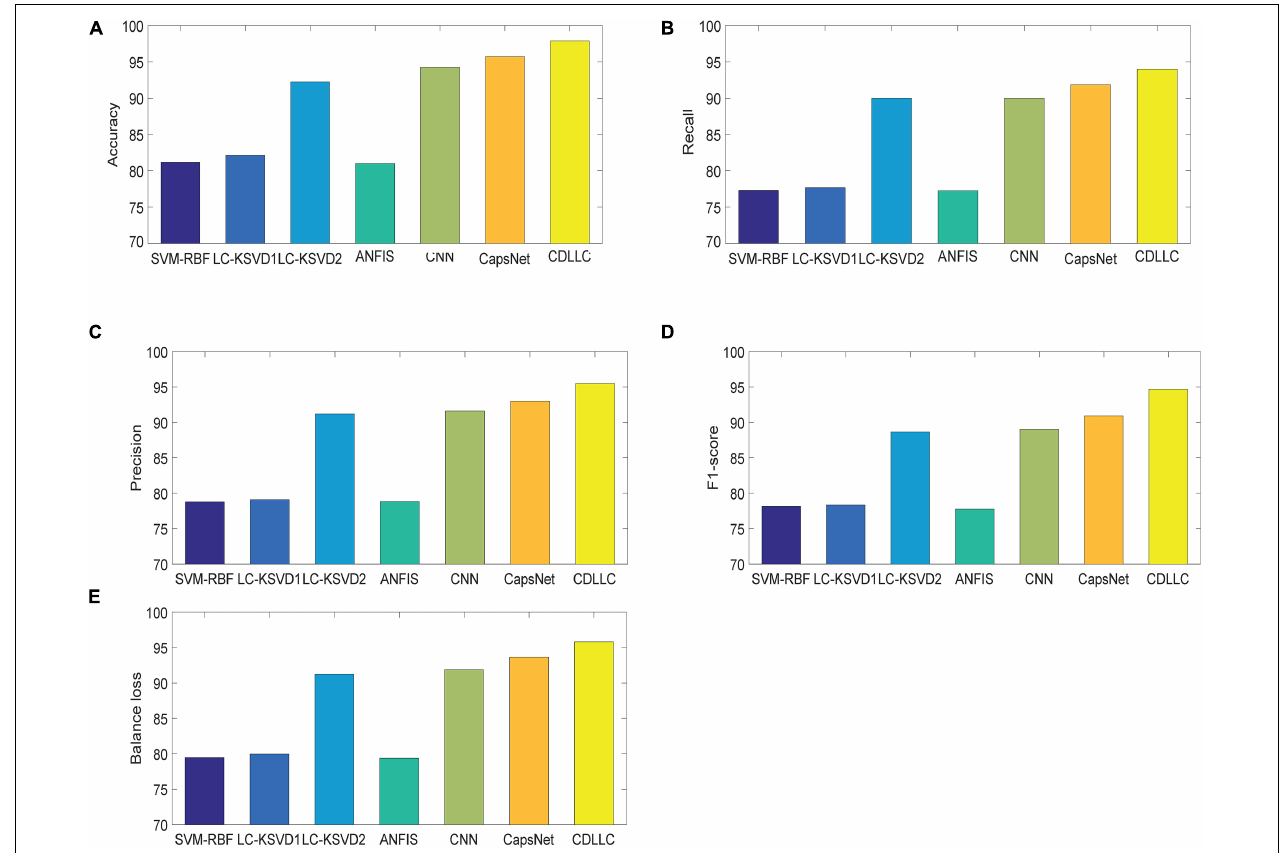
FIGURE 5 | Performance of CDLLC on the REMBRANDT dataset: (A) accuracy, (B) recall, (C) precision, (D) F1-score, and (E) balance loss.